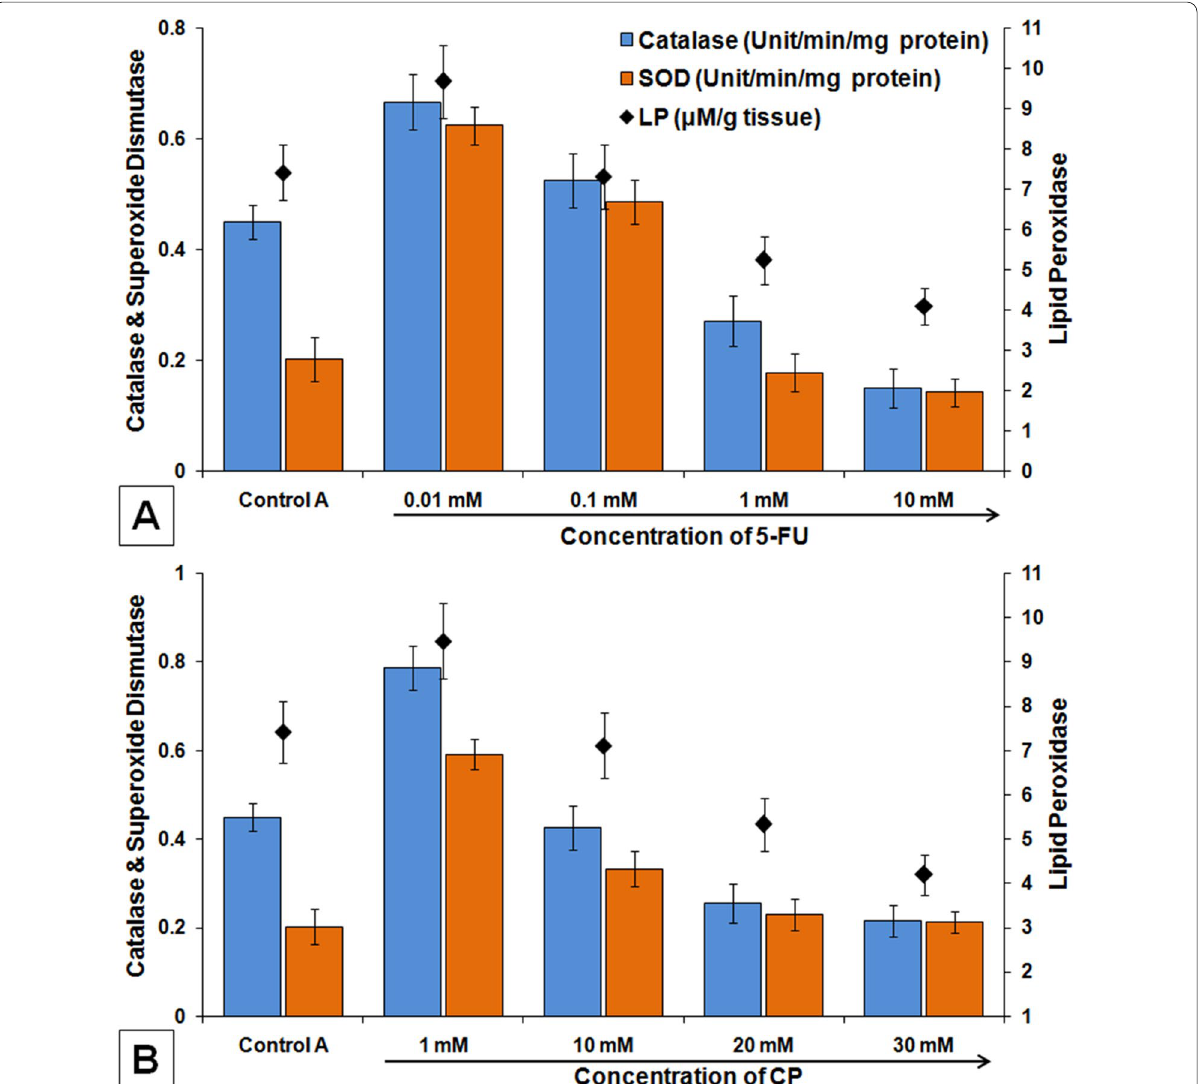
Fig. 5 Effect of different concentrations of ( A ) 5-fluorouracil and ( B ) cyclophosphamide on the activity of superoxide dismutase, catalase and lipid peroxidase of Lathyrus